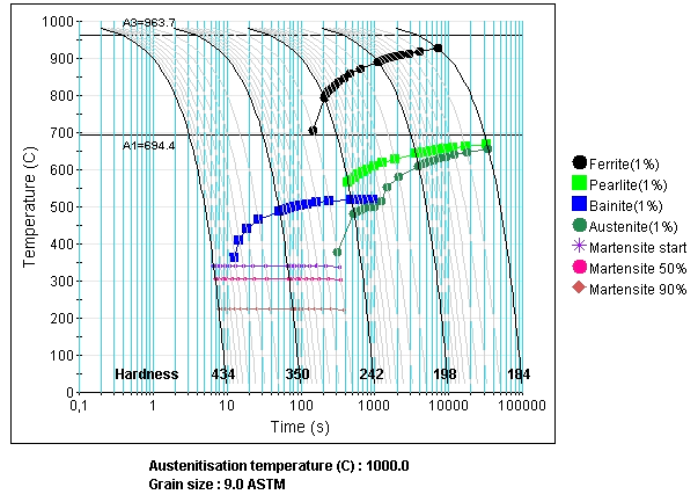
Figure 7. Predicted continuous cooling transformation (CCT) diagram of 3 Mn steel determined using the JMatPro package.